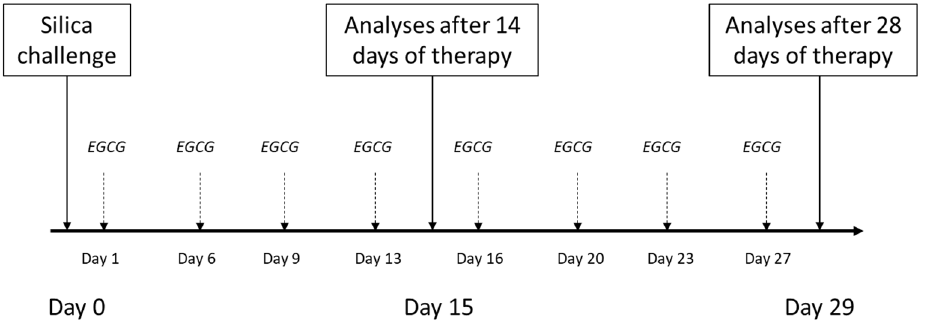
Figure 6. Schematic study protocol for induction of the silicosis and delivery of the treatment. Silica particles suspended in saline were instilled orotracheally at day 0. Treatment with intraperitoneal EGCG at a dose of 20 mg/kg b.w. was initiated the next day after silica instillation (day 1) and was given twice a week. The analyses were performed after 14 days and 28 days of the treatment admin ‐ istration.